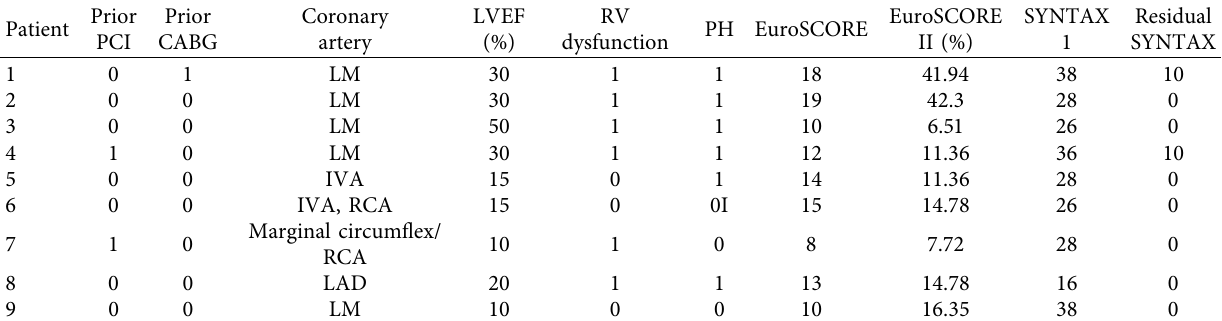
Table 2: Baseline characteristics (cardiac history, anatomy, and risk scores).